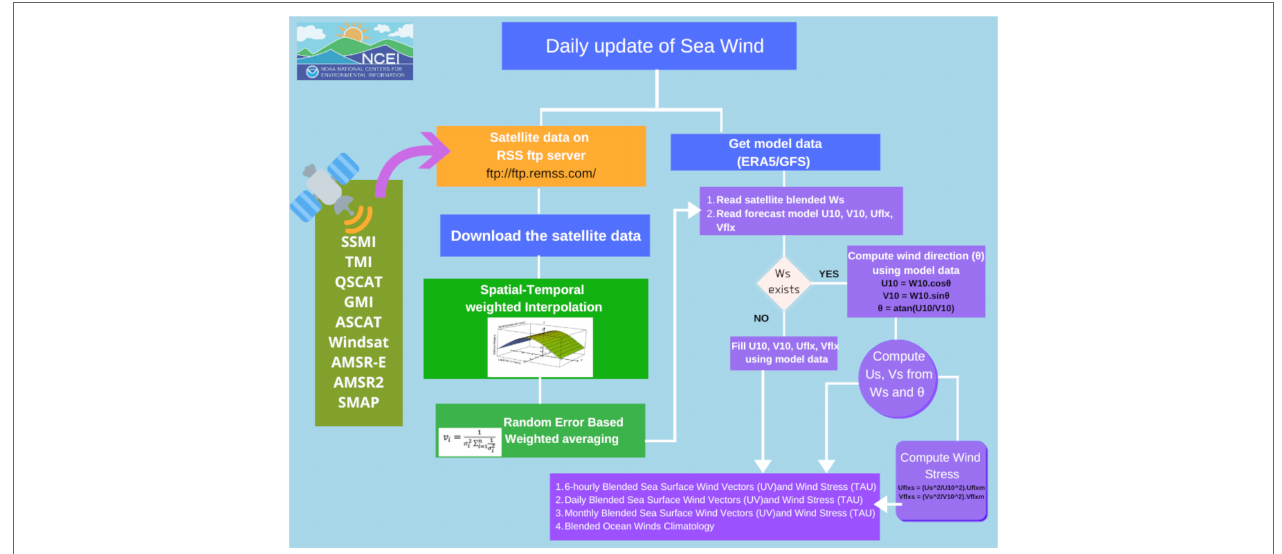
FIGURE 3 | Algorithm flowchart representing schema for version 2.0 NBS